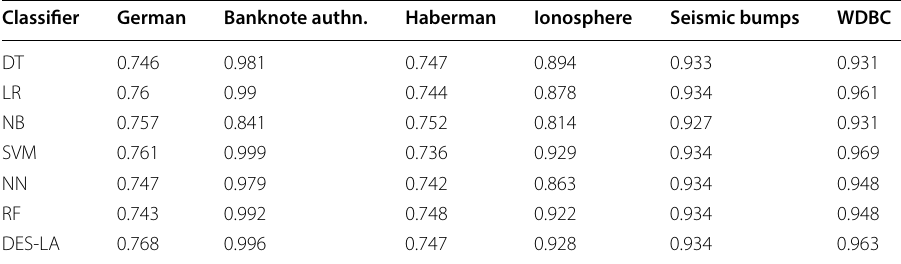
Table 3 Classifier accuracy with filtering Classifier